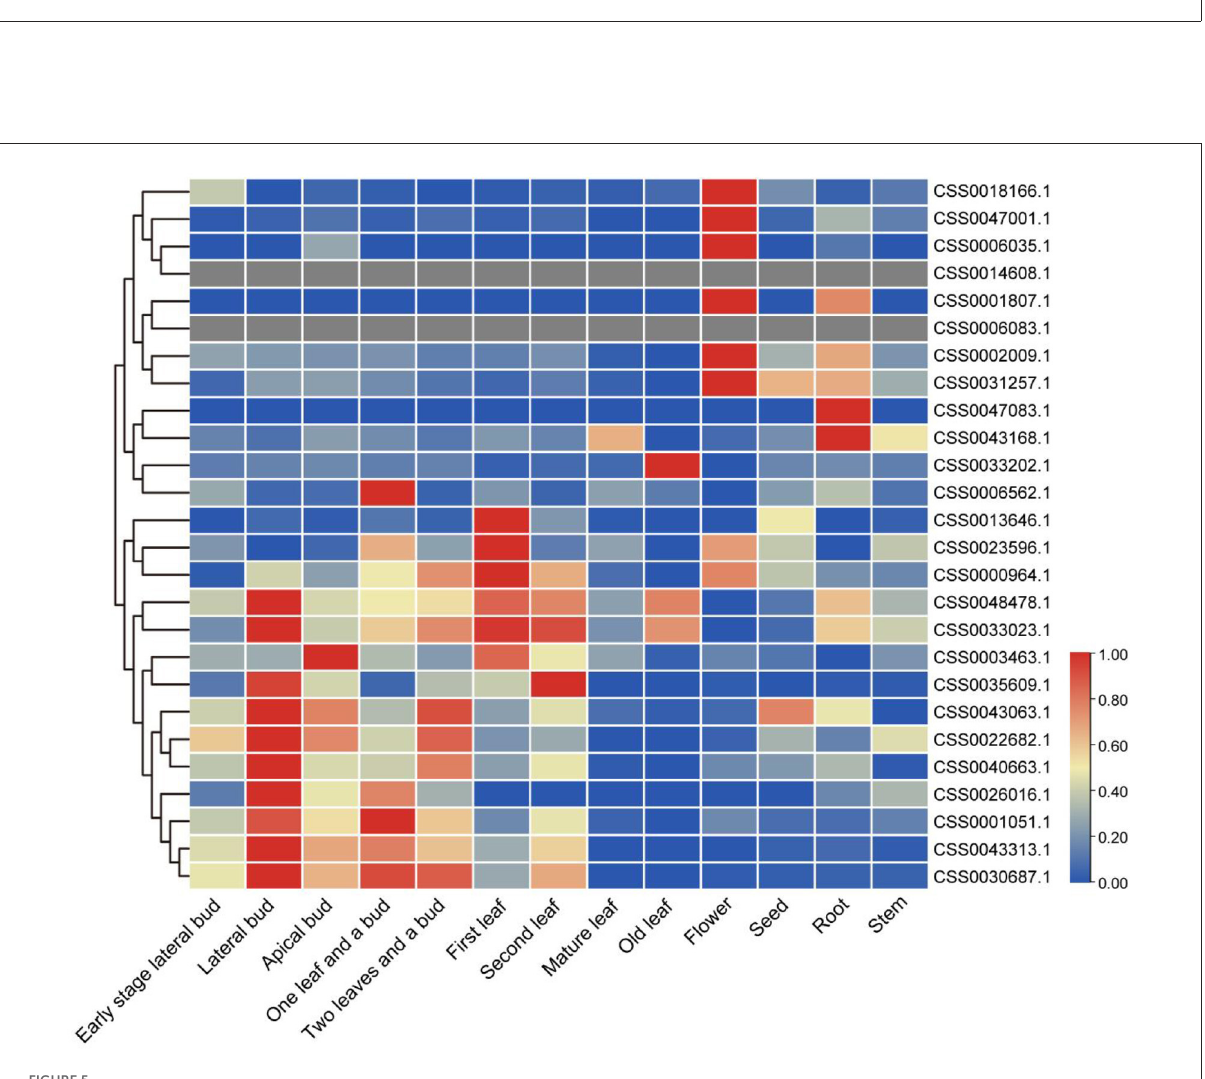
FIGURE5 Expression analysis of OVATE genes in different tea plant tissues. The red color indicates high expression and the blue color indicates low